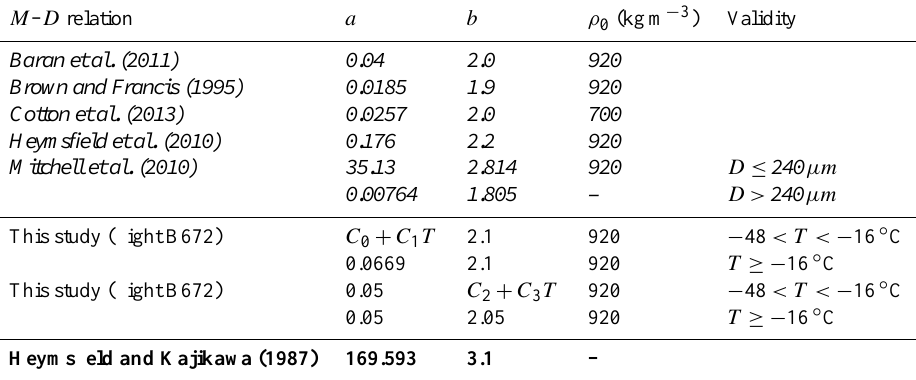
Table 1. M = aD b relations used in this study. Those in italic font are representative of pristine ice particles or aggregates. The bold font is representative of more heavily rimed particles. Two temperature-dependent relations from this study (cirrus flight B672) are also included, where the constants are C 0 = 0 . 0901, C 1 = 0 . 001449, C 2 = 1 . 9868 and C 3 = − 0 . 004059. The unit of temperature, T , is ◦ C. ρ 0 is a fixed upper limit on the value of the particle